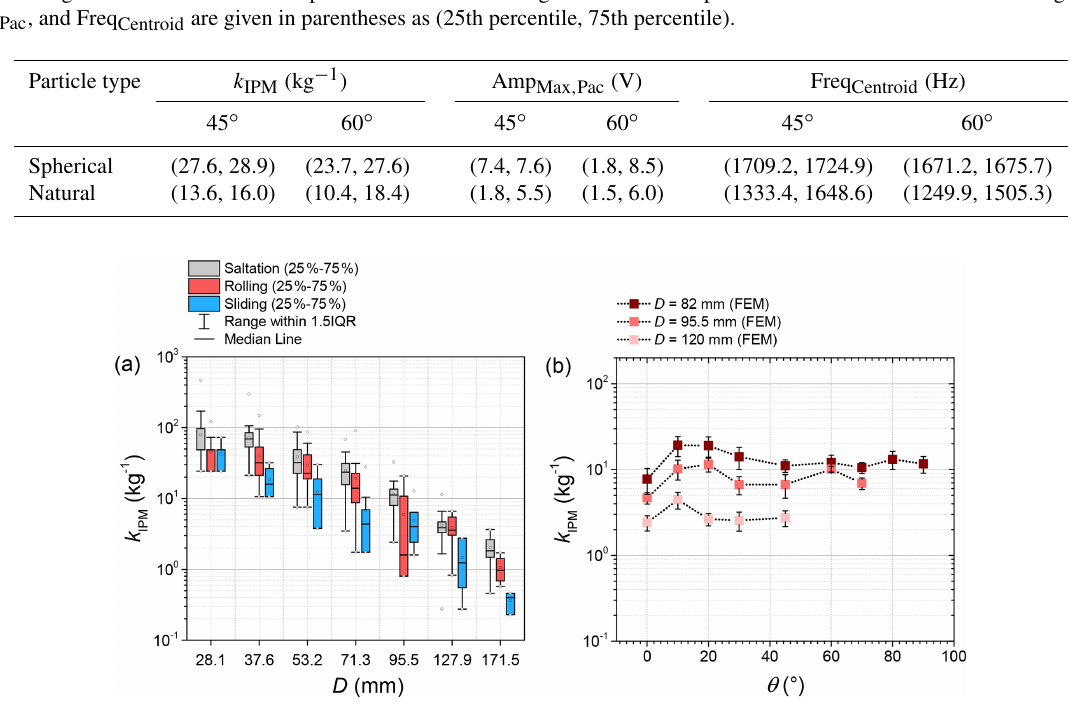
Table 5. Results from the inclined chute experiments, including impact slope angles of 45 ◦ and 60 ◦ . Characteristic values of the number of signal impulses per particle mass k IPM , the maximum amplitude Amp Max , Pac , and the centroid frequency Freq Centroid were obtained from the SPG signal. The diameter of the spheres and the b -axis length of the natural particles were 95.5mm. The value ranges of k IPM , Amp Max , Pac , and Freq Centroid are given in parentheses as (25th percentile, 75th percentile).